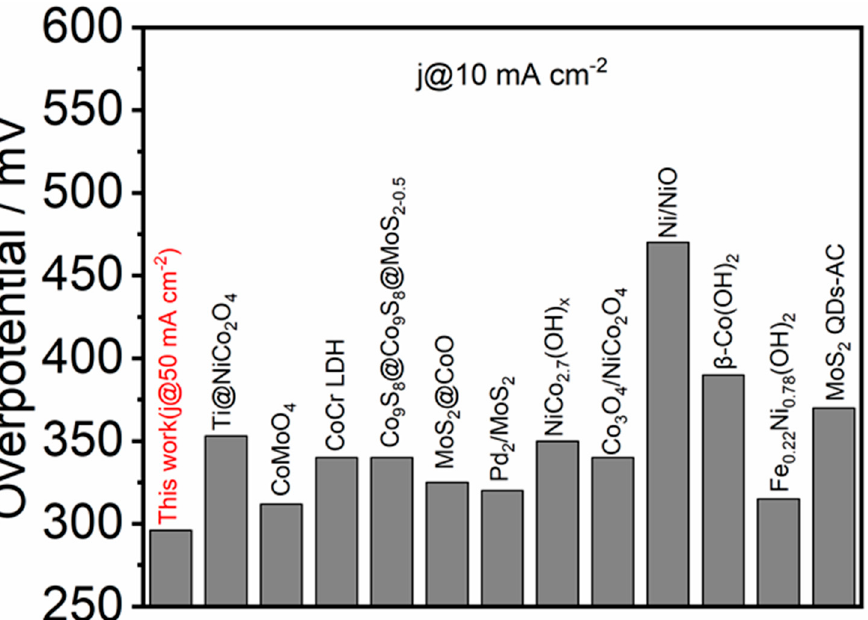
Figure 5. The comparison of OER performance for some representative non-noble electrocatalysts.